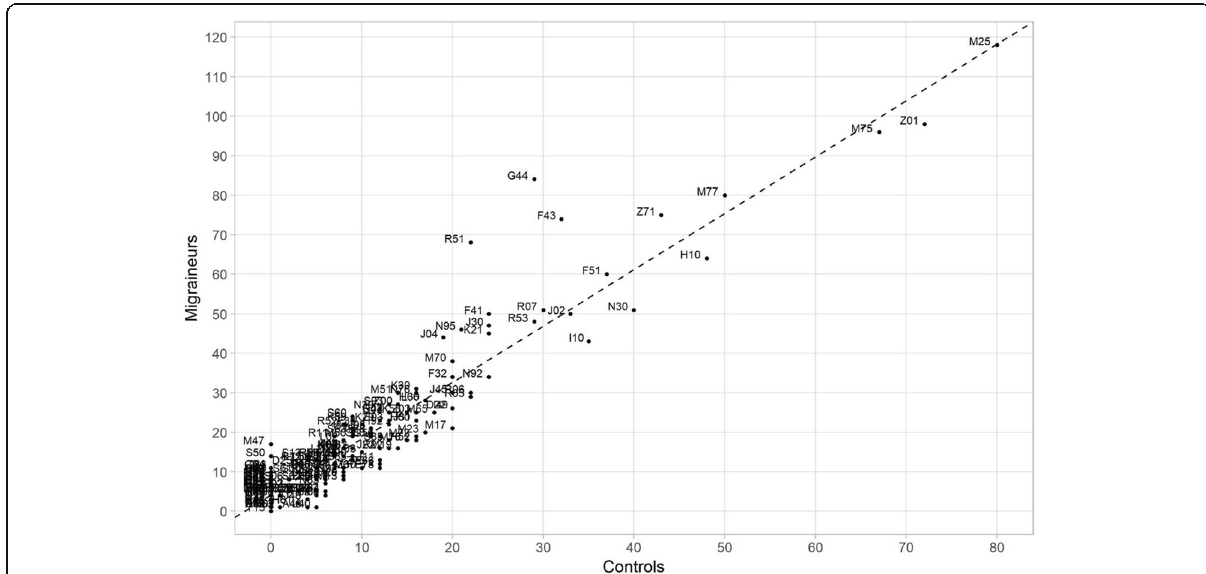
Fig. 3 Number of statistically significant phi-correlations per each comorbidity (degree) plotted in migraineurs vs controls. The dashed line represents the regression slope from regressing the number of significant phi-correlations in migraineurs on the controls. Slope = 1.43 ( p < 0.001), intercept= 4.04 ( p < 0.001), R-squared = 88.6%. The fit shows that the number of significant phi-correlations per comorbidity in migraineurs is explained quite well by the respective number in controls, when the overall increase in morbidity in migraineurs is accounted for. However, visual assessment suggests 3 outliers: F43 (reaction to severe stress, and adjustment disorders), G44 (other headache syndromes), and R51 (headache). This is confirmed by a formal mean-shift outlier test (Bonferroni corrected p -values < 0.001 for all three diagnosis